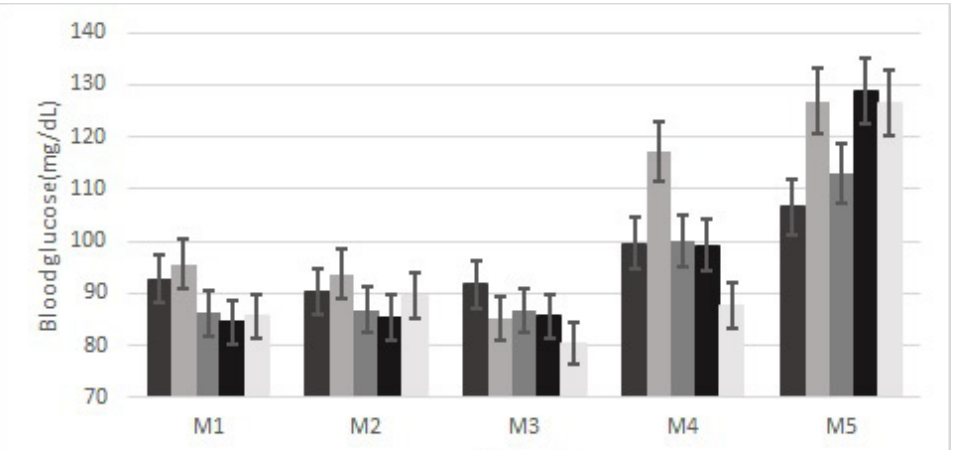
Figure 7. Graphical representation of the blood glucose variation between moments (before PAM, after PAM, after anesthetic induction (GCO) or drug administration to reach the serum level (GFLK, GCE, GDEX, GDEXCE), during clamping and ligation of the ovarian pedicle, and immediately after